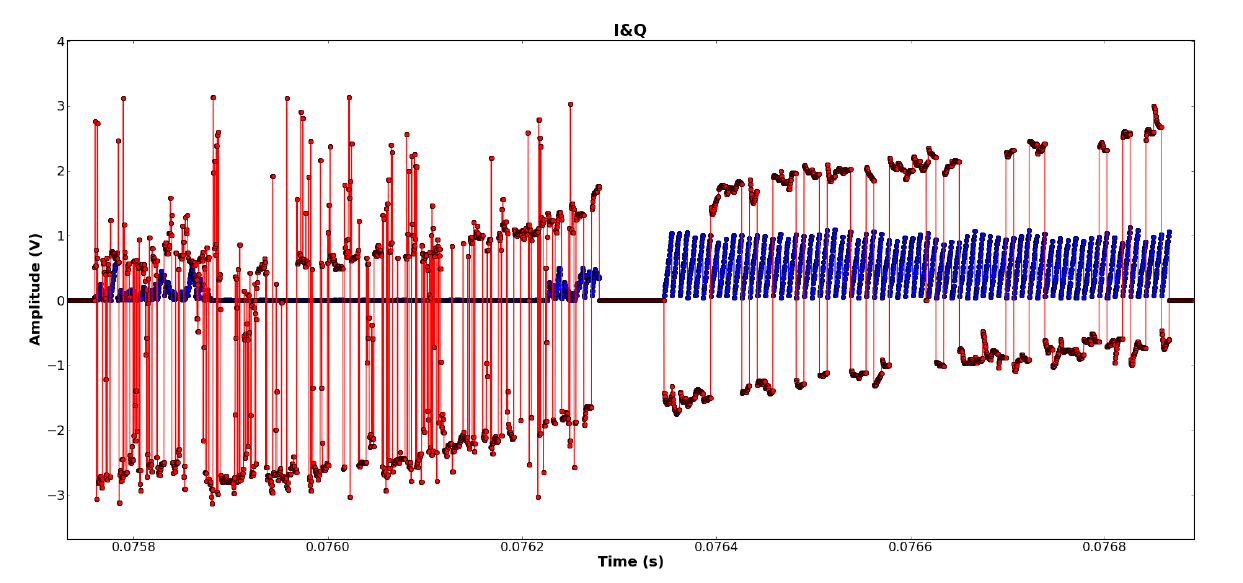
Figure 9. The amplitude (blue) and phase (red) of the integrate and dump block output for an inaccurately ( left ) and an accurately ( right ) synchronized